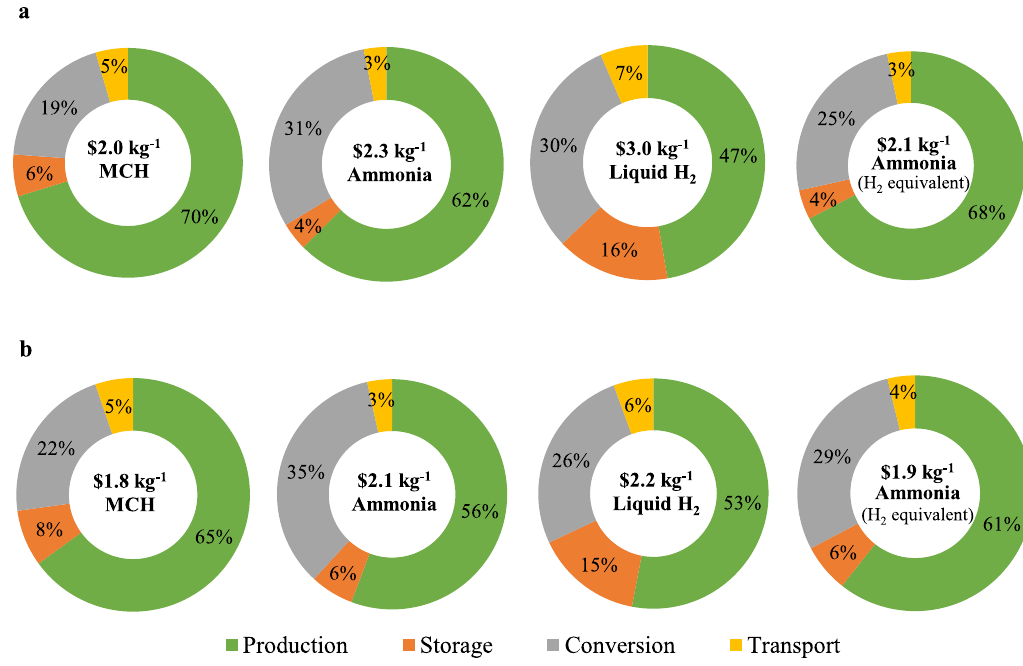
Fig. 3 Cost breakdown of levelized cost of hydrogen (LCOH) for delivery of the potential products to Japan. a and b are for 2030 (3 Mt of hydrogen) and 2050 (20 Mt of hydrogen), respectively. The costs are mean values calculated according to offshore wind conditions over the 30-year period. Results from the baseline scenario are presented. Conversion indicates expenses were appropriate for hydrogen compression, liquefaction, ammonia synthesis, and for hydrogenation and dehydrogenation of the chemical carriers. Transport de fi nes costs for capital and energy included in shipping and pumping. Individual items are indicated by colors as de fi ned in the legend. Expenses for electricity are included in each item based on its corresponding consumption. MCH represents the hydrogen transport mechanism as in